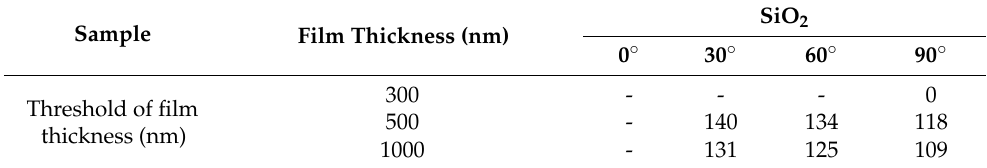
Table 4. Film thickness thresholds of samples affected by the shadow effect on a SiO 2